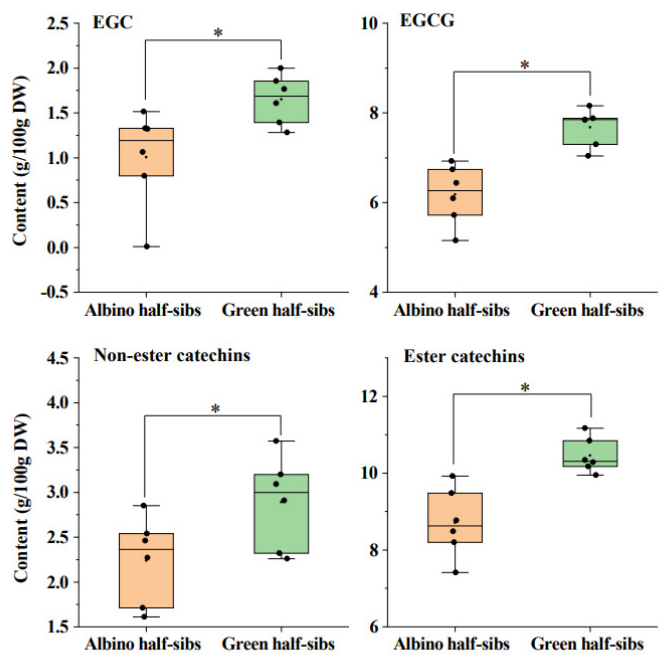
Figure 1. The contents of EGC, EGCG, non-ester catechins, and ester catechins from the albino half-sibs were significantly lower than those of the green half-sibs of Camellia sinensis cv Baijiguan . Asterisk represents statistical significance ( p < 0.05).